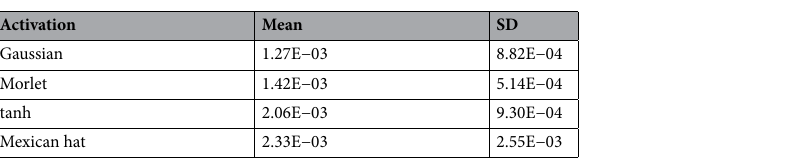
Table 4. Average and SD of relative L 2 error of the proposed method in solving Burger’s equation (case 1) using different activation function compared against the analytical solution over 10